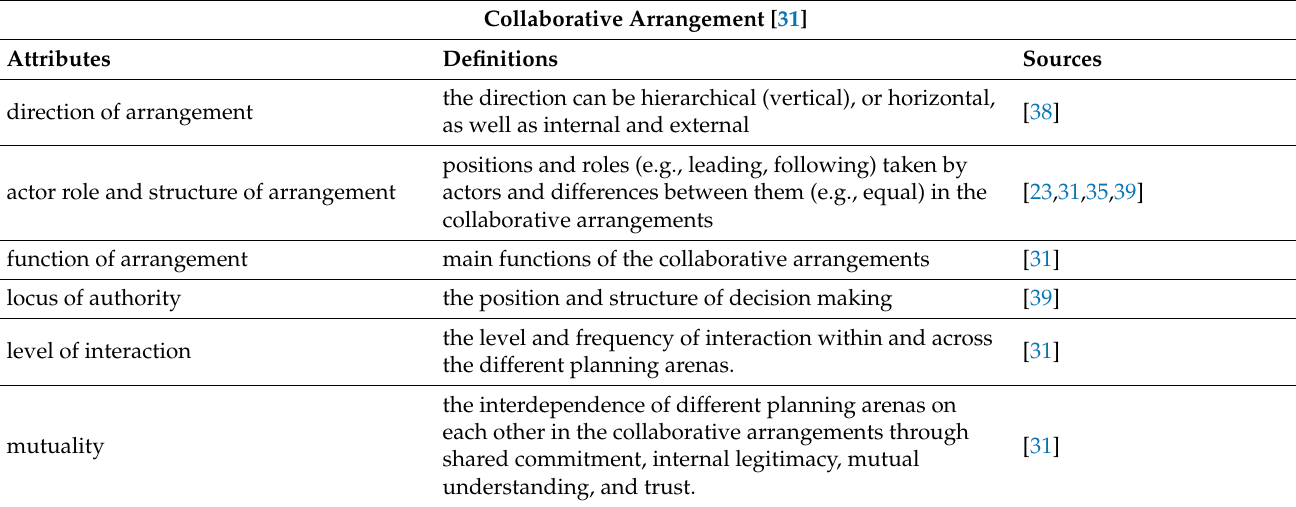
Table 2. Conceptual framework for the analysis of collaborative